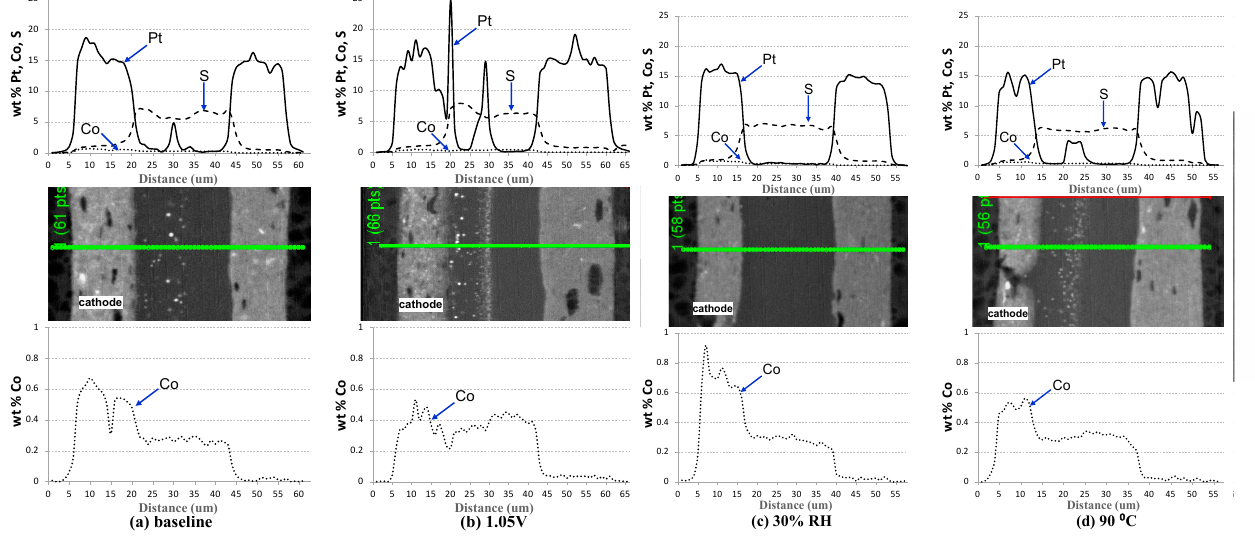
Figure 9. Post-test analysis of Pt 3 Co parametric operational study at subscale plan form midpoint consists of cross-section back-scattered SEM images and corresponding Pt, Co and S elemental profiles taken along lines indicated. ( a ) Baseline, ( b ) Higher upper potential (1.05 V), ( c ) Lower RH (30%) and ( d ) Higher Temperature (90